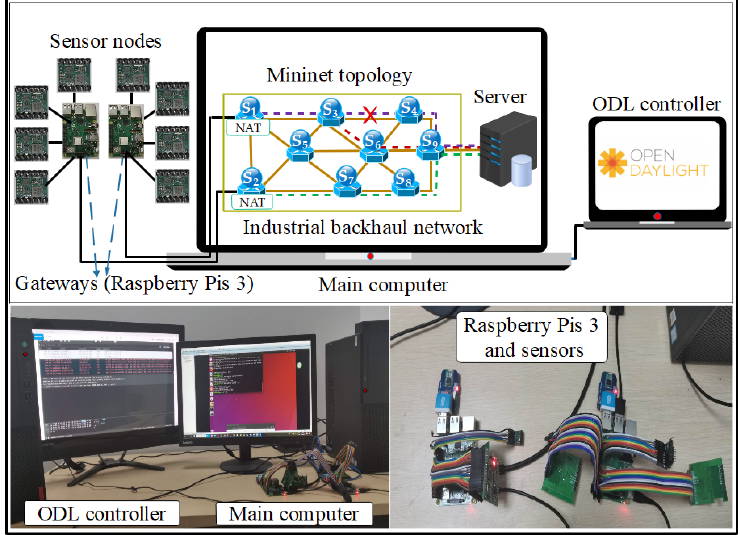
Figure 13. Testbed experiment.